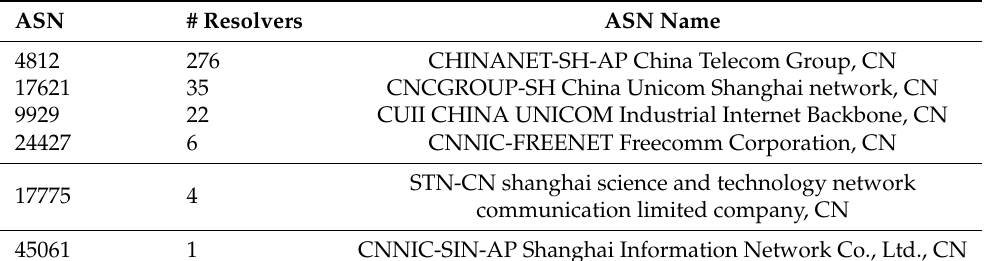
Table 5. ASN and ASN name of the open DNS resolvers.